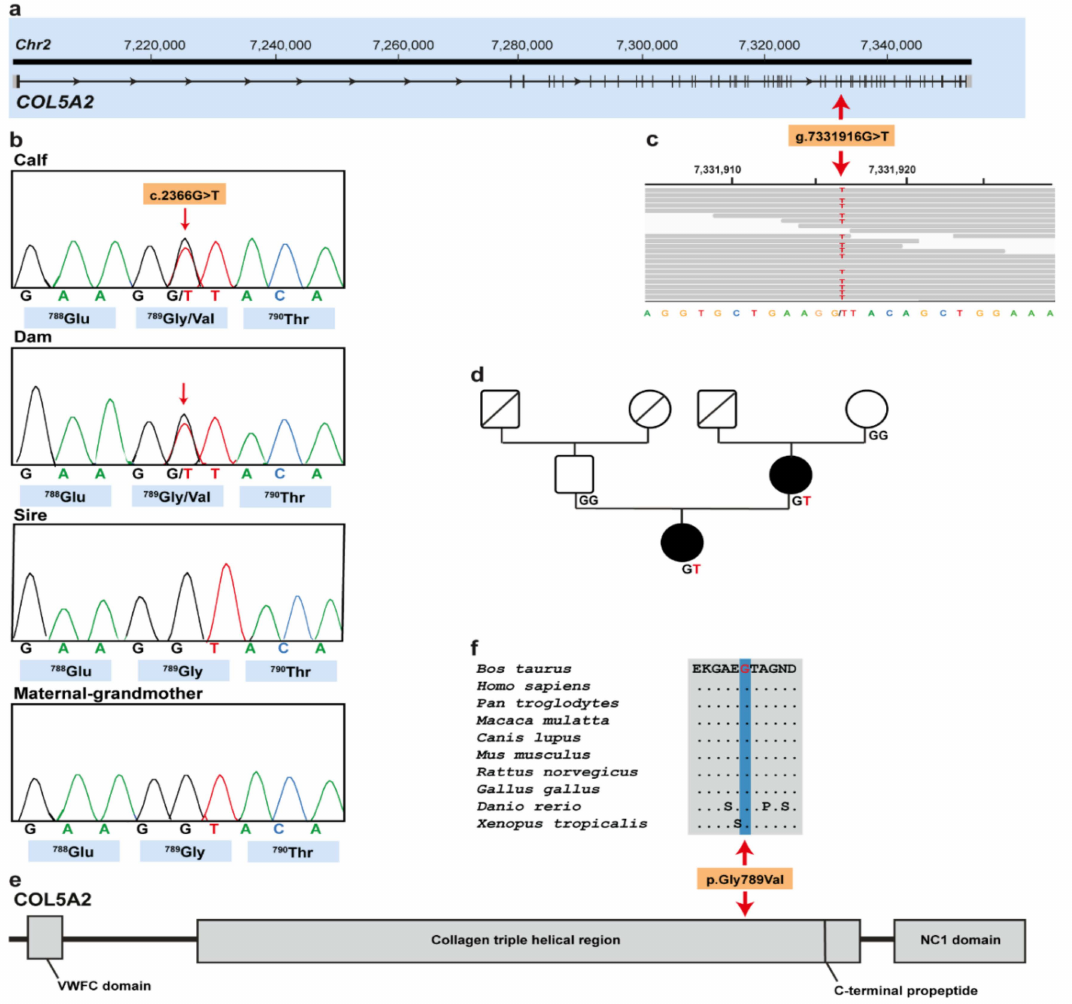
Figure 4. cEDS-associated COL5A2 missense variant in Holstein cattle. ( a ) COL5A2 gene structure showing the variant location on chromosome 2, exon 35 (red arrow). ( b ) Electropherograms of the calf, dam, sire, and maternal-grandmother. ( c ) Integrative Genomics Viewer (IGV) screenshot presenting the g.7331916G > T variant in the a ff ected calf. ( d ) Pedigree of the cEDS-a ff ected Holstein family. Males are represented by squares and females by circles. A ff ected animals are represented with full black symbols, while non-a ff ected animals are represented by full white symbols. Unknown genotypes are represented by symbols with a diagonal line. COL5A2 genotypes are shown for all available animals. ( e ) Schematic representation of COL5A2 protein and its three functional domains. ( f ) Multiple sequence alignment of the collagen alpha-2(V) chain of the COL5A2 protein encompassing the region of the p.Gly789Val variant demonstrates complete evolutionary conservation across